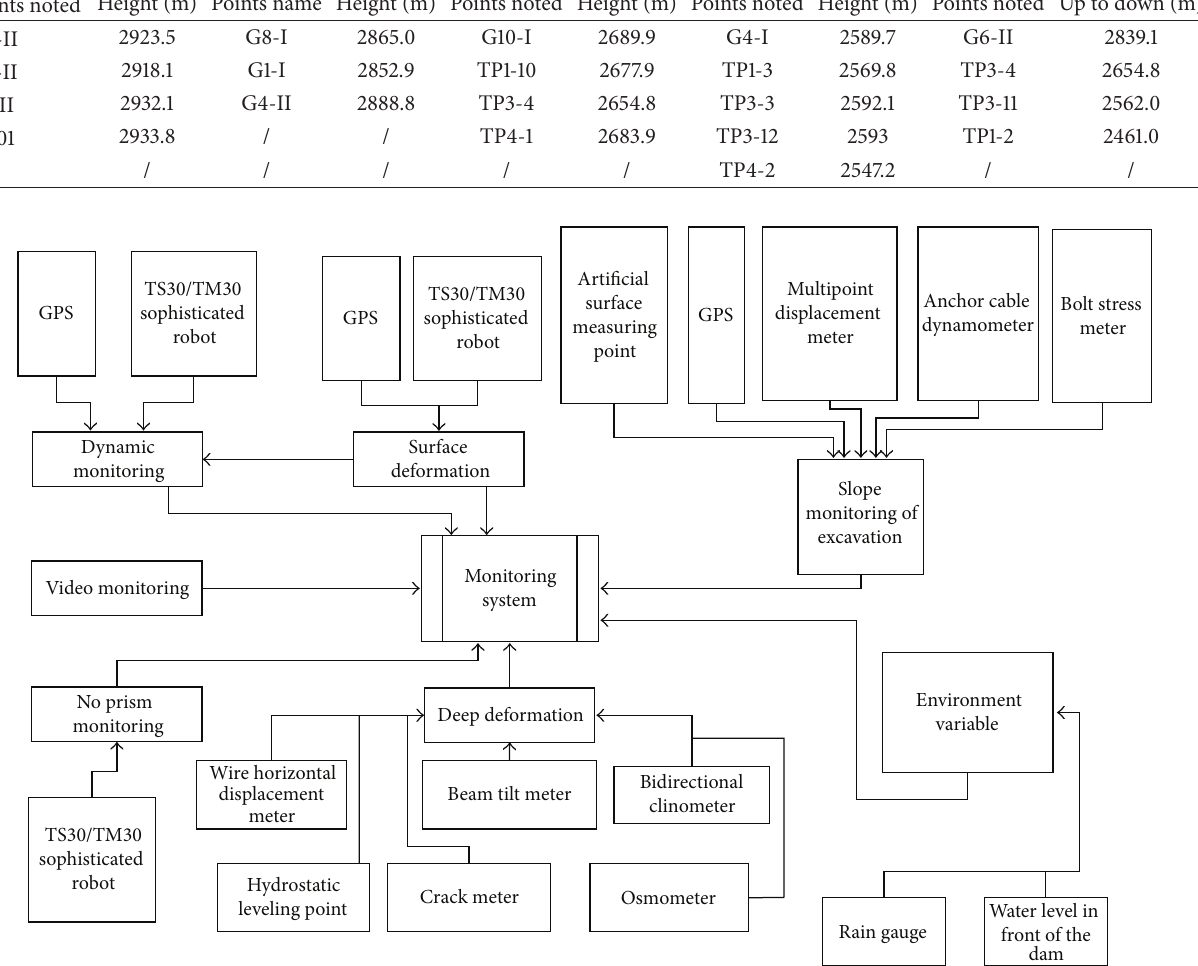
Figure 2: Constitution sketch of monitoring